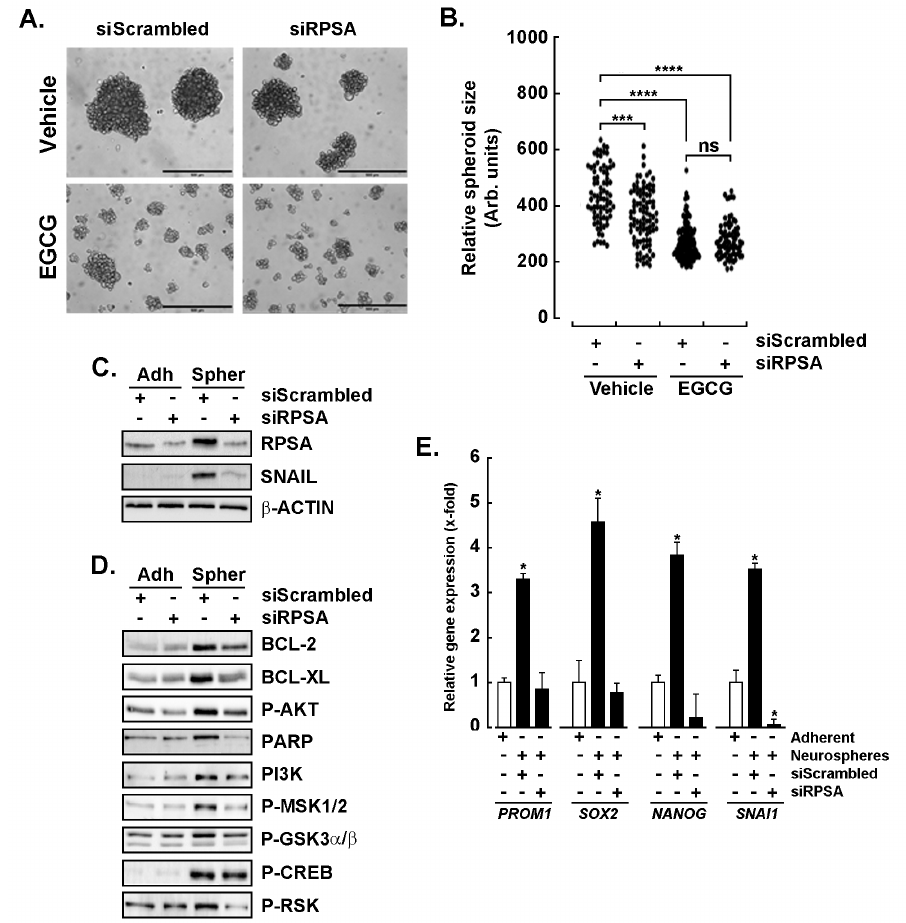
Figure 4. Repression of RPSA alters spheroids formation and prevents the acquisition of a cancer stem cell phenotype. ( A ) U87 glioblastoma monolayers were transiently transfected with a scrambled sequence (siScrambled) or with a siRNA directed against RPSA (siRPSA). Next, the cells were cultured with the Tumorsphere Medium Xf with Supplement Mix for 72 h in the absence or presence of 30 μ M EGCG. Representative phase contrast pictures of the spheroids formed were taken, and ( B ) spheroid size was quantified as described in the Methods section. (*** = 0.001 ≥ p ; **** = 0.0001 ≥ p ; ns = non significant). Cell lysates were harvested from adherent, or spheroids obtained at 72 h and upon transient siScrambled or siRPSA transfection. Western blot analysis of ( C ) EMT markers RPSA, SNAIL, and β -Actin, as well as the indicated ( D ) apoptosis and transducing intermediates expression was performed as described in the Methods section. Representative blots for each marker are shown from three independent experiments. ( E ) Total RNA was extracted from adherent or neurospheres and RT-qPCR analysis was used to assess the expression of CSC markers ( PROM1 , SOX2 , and NANOG ), and EMT marker SNAI1 . Probability values of 0.05 were judged significant and indicated as (*).